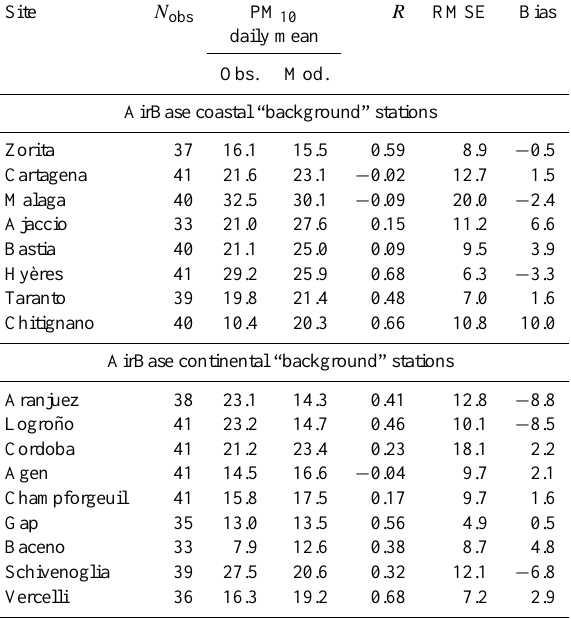
Table 9. R , bias and RMSE for the daily mean averaged PM 10 (µgm − 3 ) surface concentrations (except for the Lampedusa mea- surements corresponding to total suspended